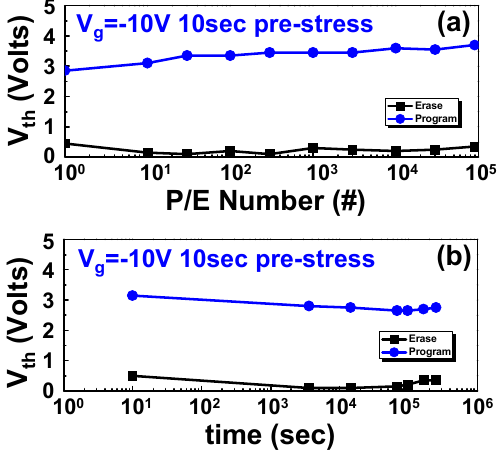
Figure 10. Endurance and retention characteristics of the ONO-buried oxide poly-Si nanowire FETs. The programming/erasing window is still larger than 2 V after 100 K programming/erasing operation cycles or a long storage period of 3